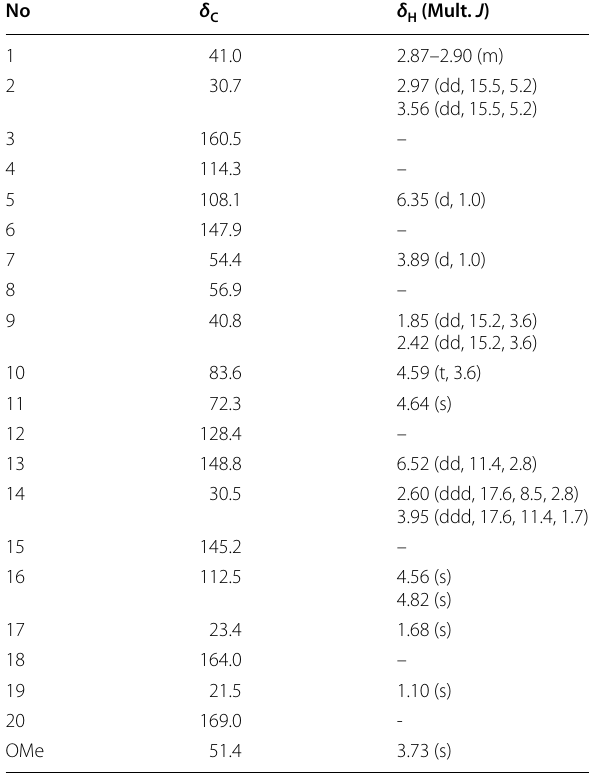
Table 1 13 C NMR (125 MHz) and 1 H NMR (500 MHz) spectroscopic data for compound 1 (δ in ppm and J in Hz) in CDCl 3